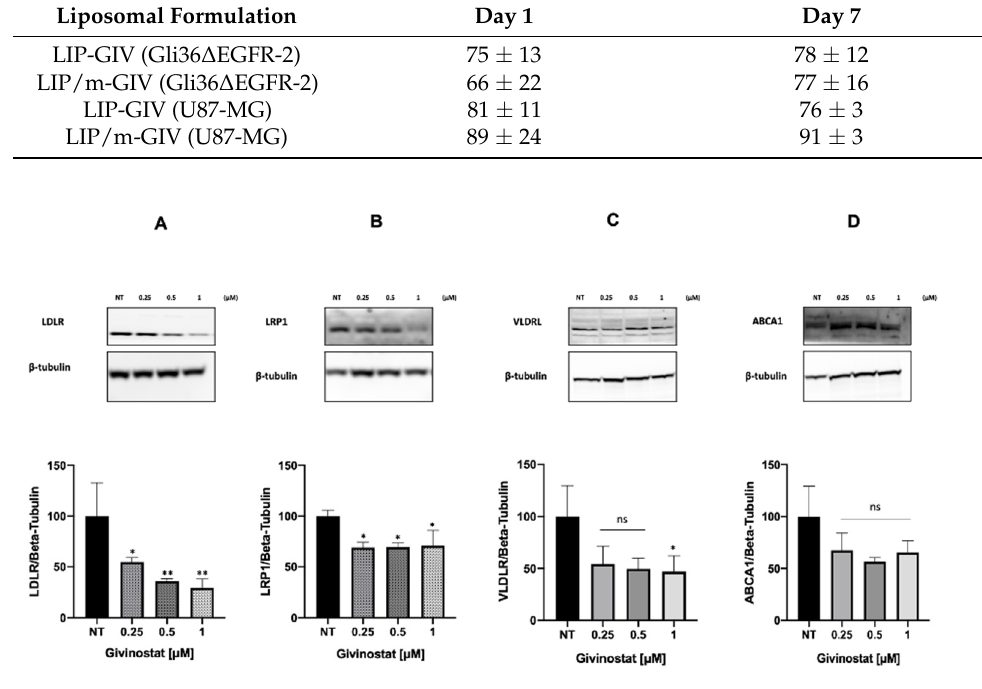
Figure 8. WB representing the effect of LIP-GIV on the expression of LDLR ( A ), LRP1 ( B ), VLDLR ( C ), and ABCA1 ( D ) receptors in Gli36 ∆ EGFR-2 after 24 h, with quantitative graphs. Each graph is the result of three independent experiments. β -tubulin was used as a normalization protein. Ns,